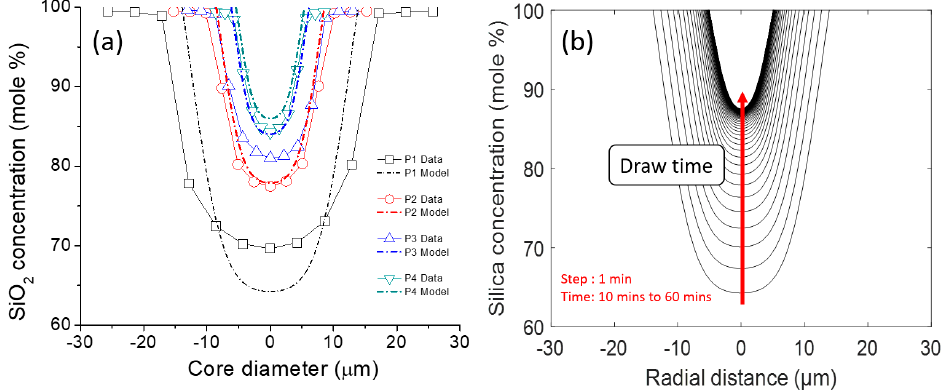
Figure 3. ( a ) Comparison between modeled data and measured data (using Equations (4)–(6) from the text). ( b ) Evolution of silica concentration profile as a function of time with a time step interval of 1 min.